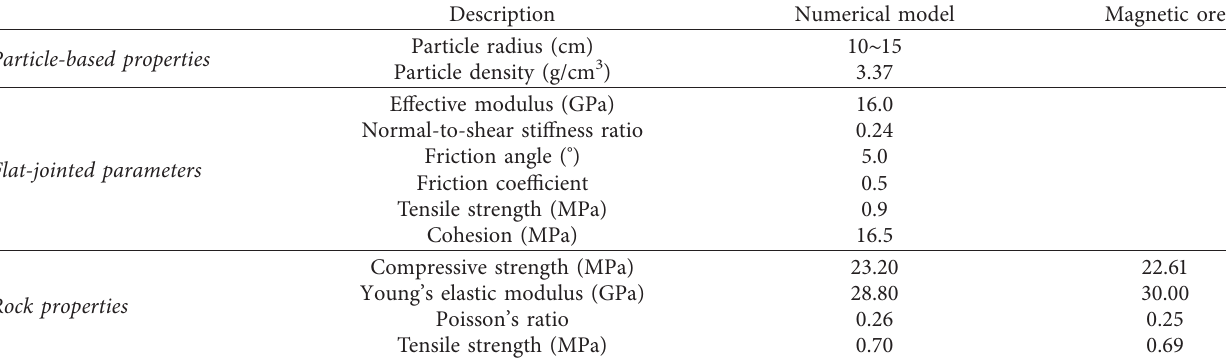
Table 1: Calibrated parameters for the numerical model.